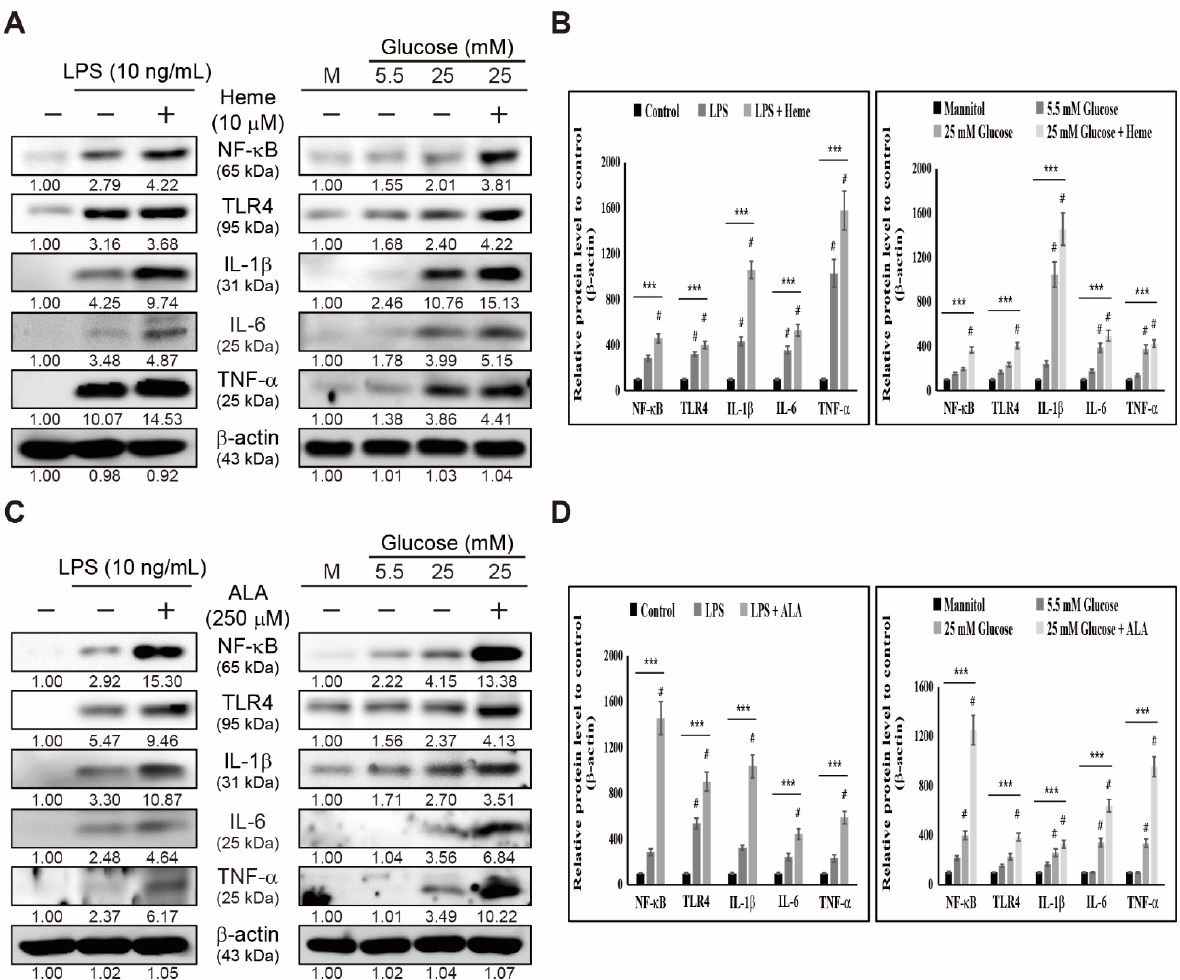
Figure 3. Heme biosynthesis induces inflammatory responses. ( A ) Western blotting of TLR4, NF ‐κ B, IL ‐ 6, IL ‐ 1 β , and TNF